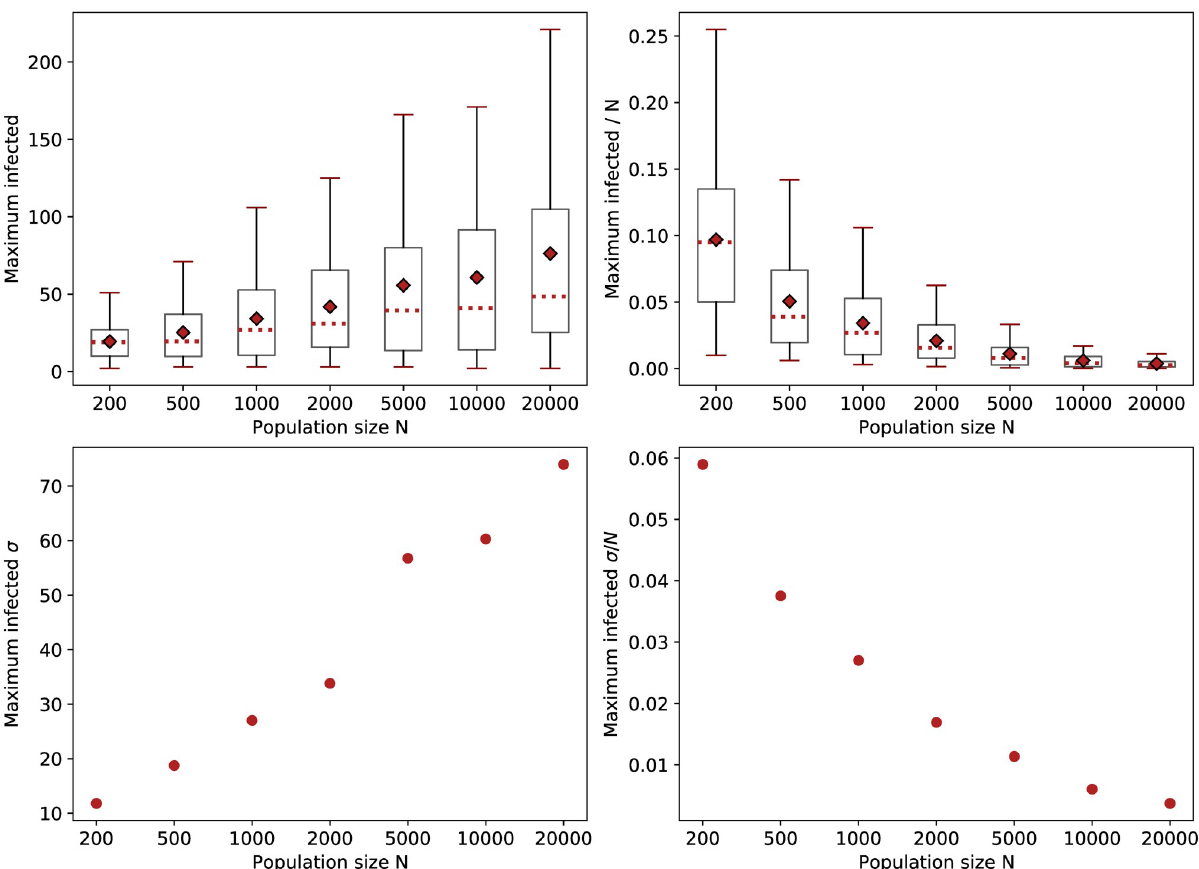
Fig 5. Uncertainty of simulation results with regard to the infection peak. Values from 80–100 runs plotted for different population sizes, K = 10, τ t = τ r = 0.1, p a = 0.2. On top, boxplots with quartiles represented via whiskers, medians via red dotted lines, and averages via red diamonds; the standard deviations σ are given below. The left-hand side displays absolute values, whereas on the right all the variation levels are scaled down by N .